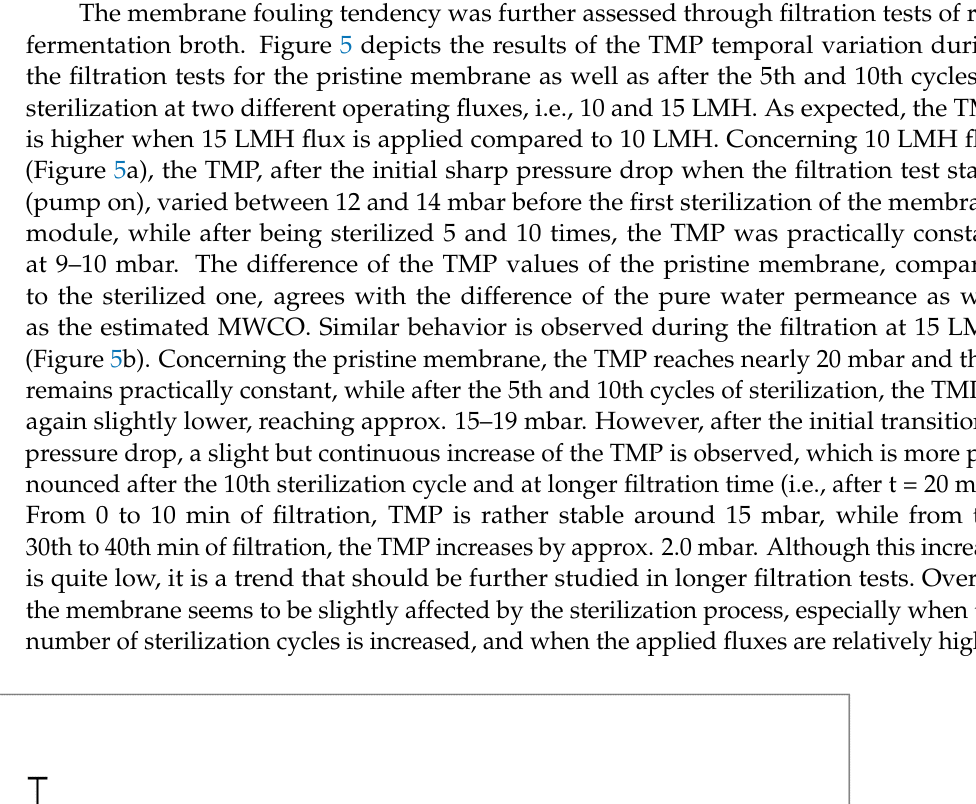
Figure 3. Typical data processing methodology for estimation of molecular weight cut-off (MWCO) from dextran rejection test results (data from the test after the 2nd sterilization cycle): ( a ) typical high performance liquid chromatography (HPLC) chromatogram from feed and permeate sample; ( b ) plot of the membrane rejection efficiency, determined by taking the ratio of RI time-series data of permeate and feed; ( c ) calibration curve with polysaccharide standards.